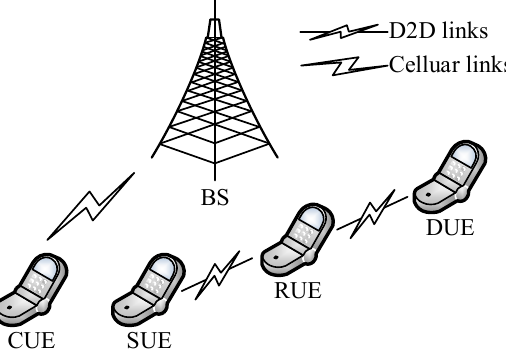
Figure 1. System Figure 1. System model.